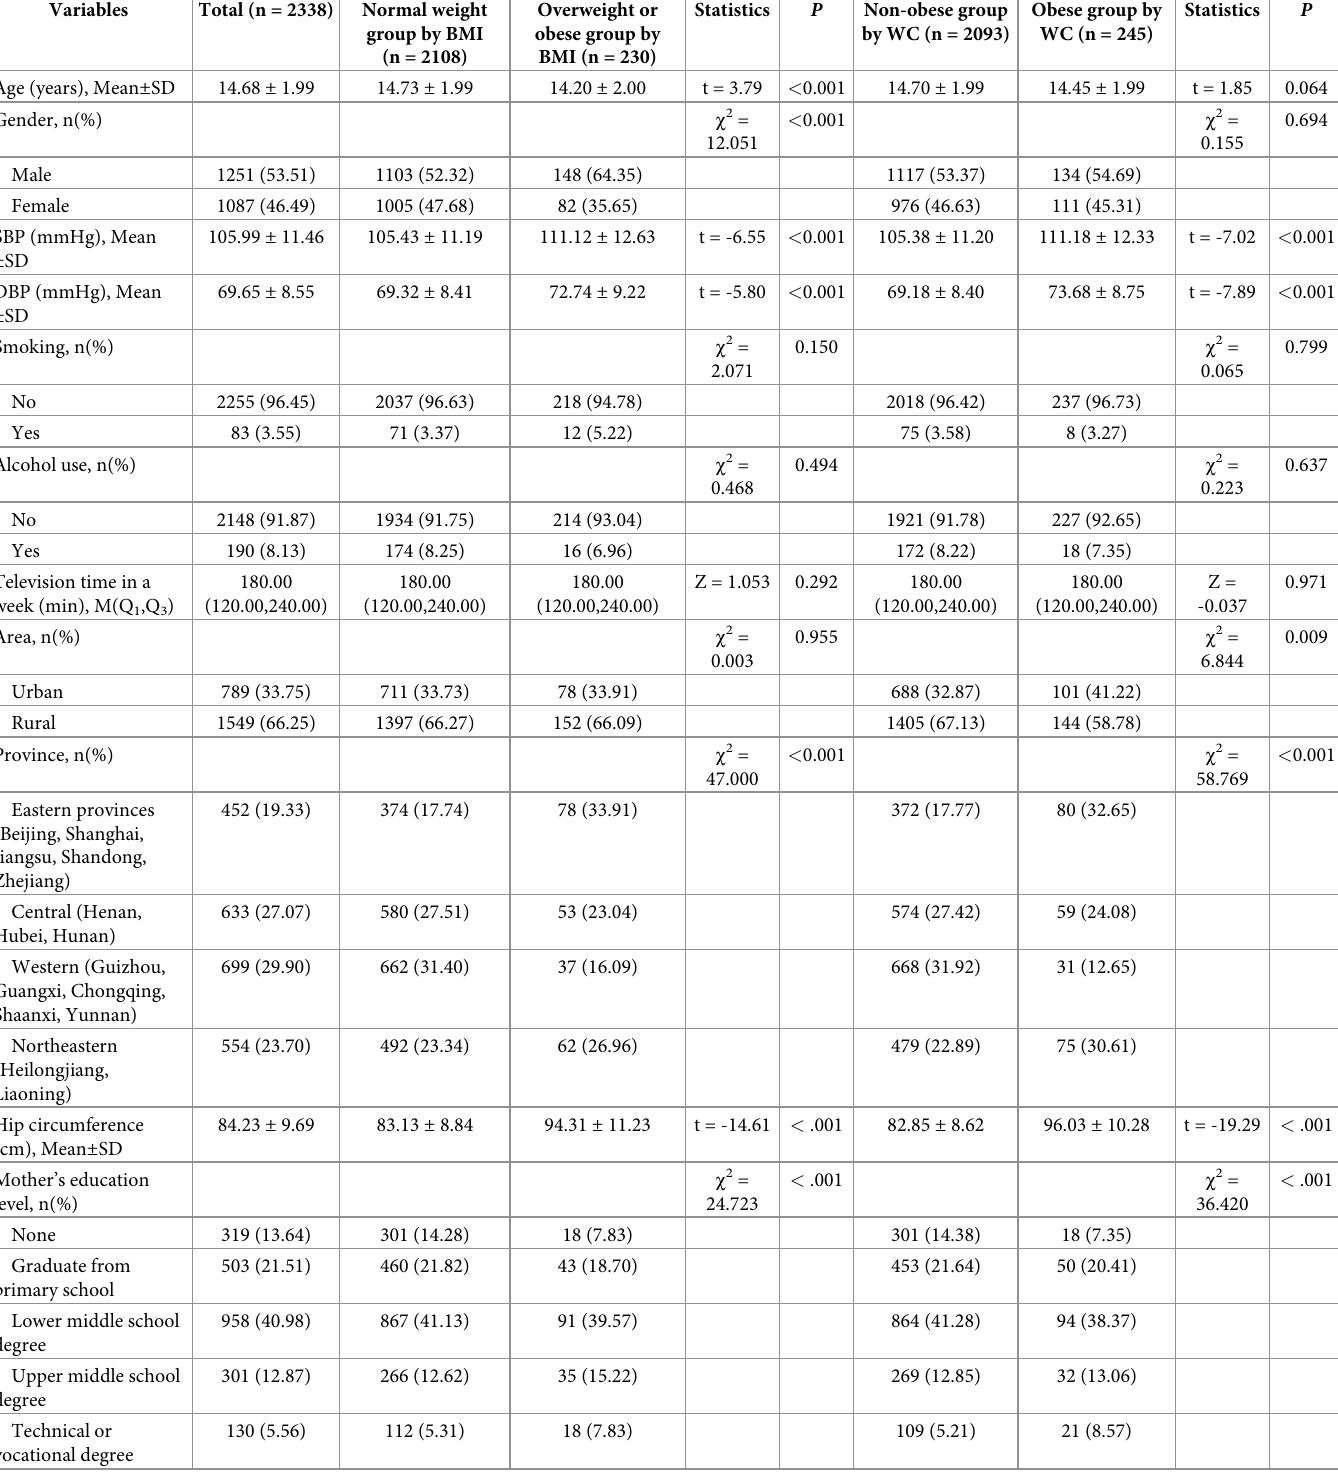
Table 1. Characteristics of the included children and